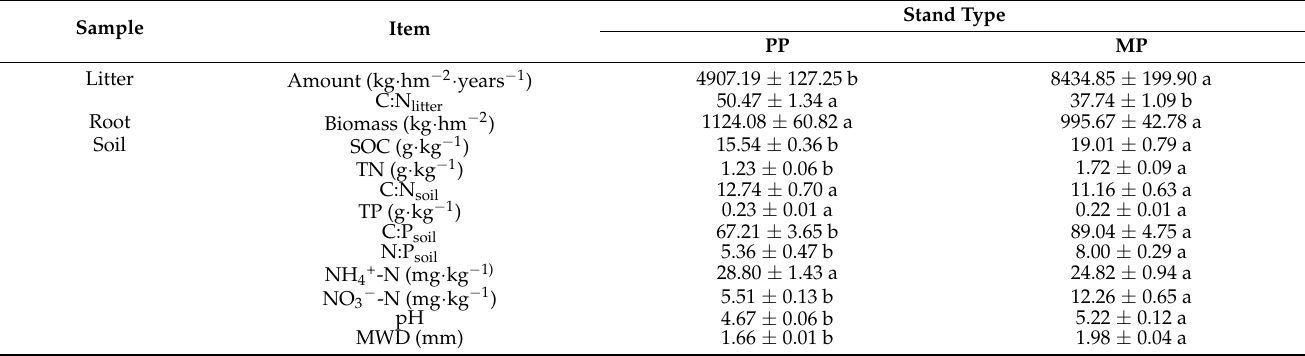
Table 2. Plant and bulk soil properties in PP and MP (mean ± standard error, n = 5).